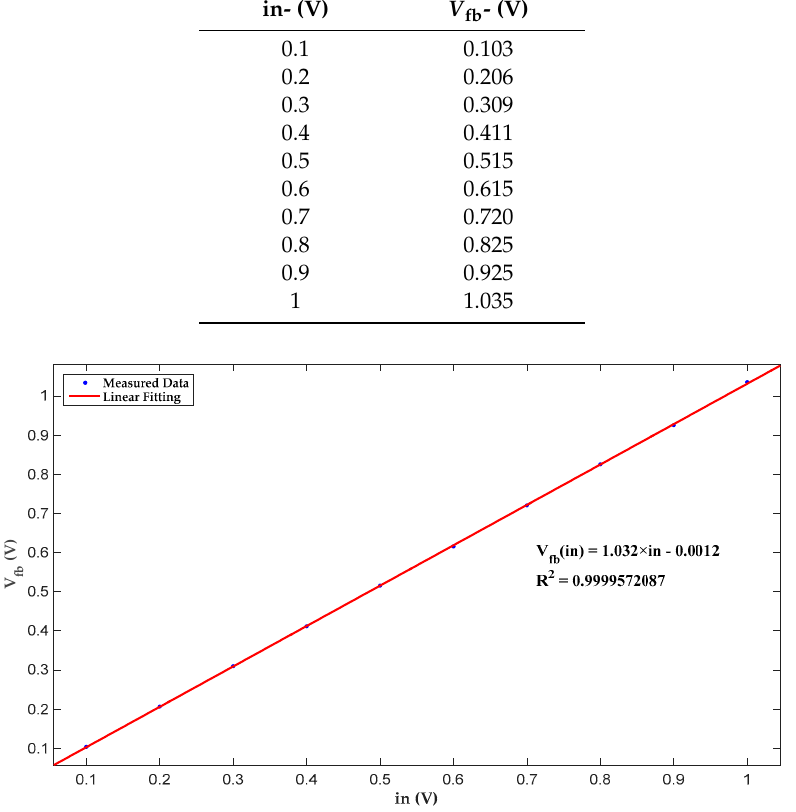
Table 1. Linearity simulation results of the proposed nonlinear multiplier.